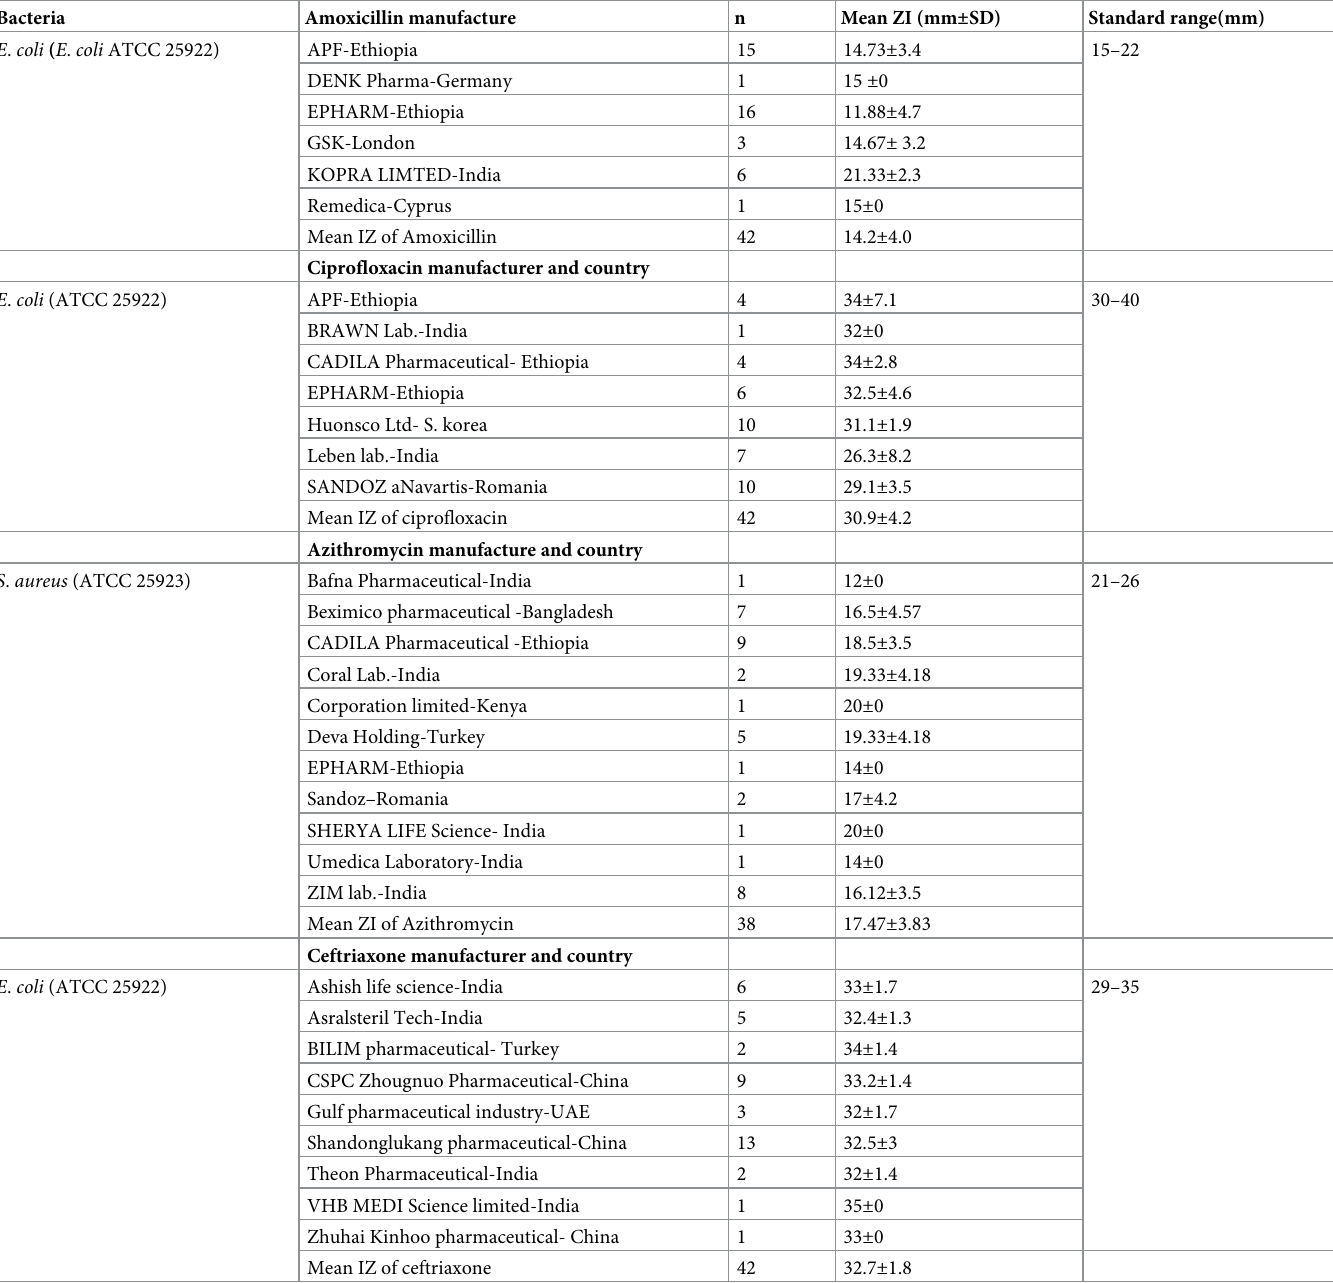
Table 3. Mean zone of inhibition of selected antibiotics collected from pharmacies found in Adama, Ethiopia, March 2018 to June 2018.